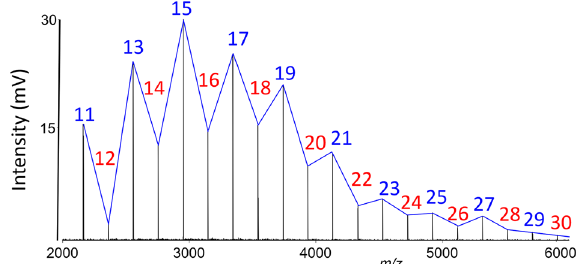
Figure 2. Part of the mass spectrum obtained via laser desorption ionisation of AuNPs where intensities of Au m + ions correspond to stability, revealing odd–even alternations. Conditions: positive reflectron ion mode, laser energy 130 a.u. Lines connecting maxima/minima in the mass spectrum have no physical meaning; they are used only for the sake of clarity. Blue and red numbers indicate m values.